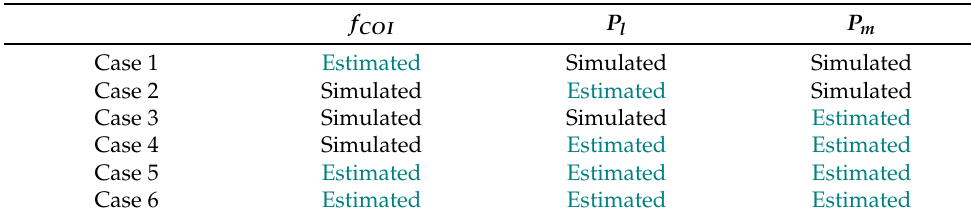
Table 1. Description of the study cases.